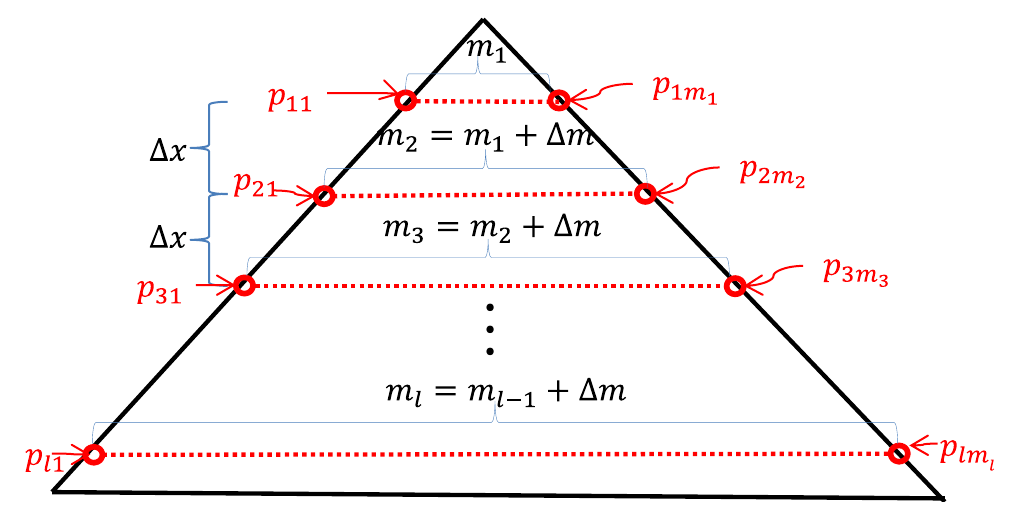
Figure 5. Scanned laser (dotted) lines on the triangle planar board.